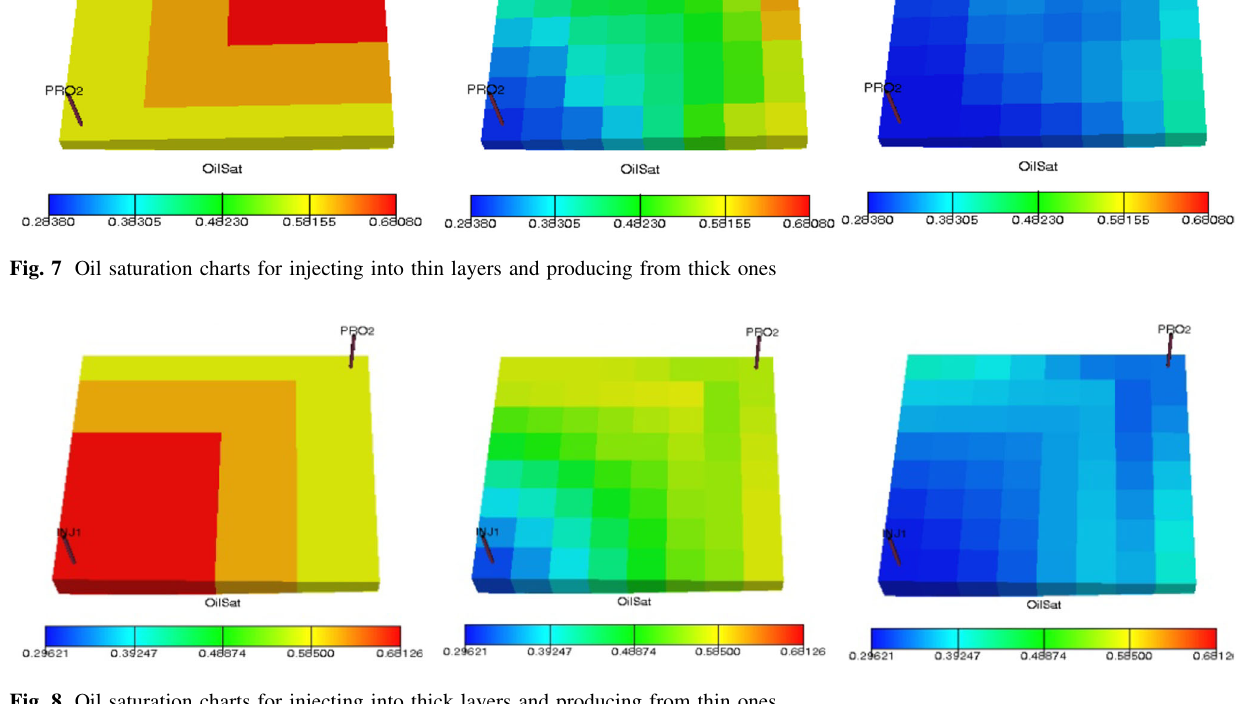
Fig. 8 Oil saturation charts for injecting into thick layers and producing from thin ones